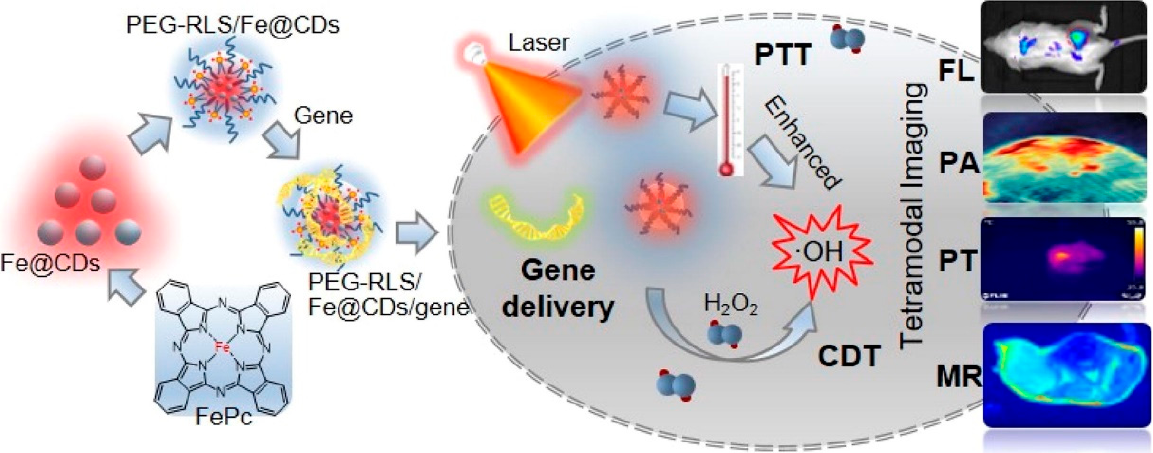
Figure 4. Graphical representation of the iron-doped carbon dots as a theranostic agent for PTT, gene delivery, and multimodal (MR/PA/PT/FI) imaging-guided PTT/chemodynamic therapies. Reproduced with permission [129]. Copyright 2021, Elsevier.